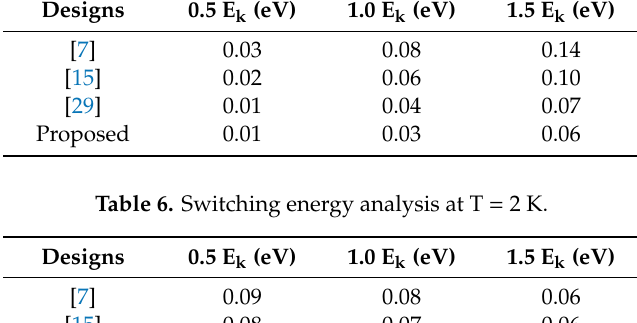
Table 6. Switching energy analysis at T = 2 K.